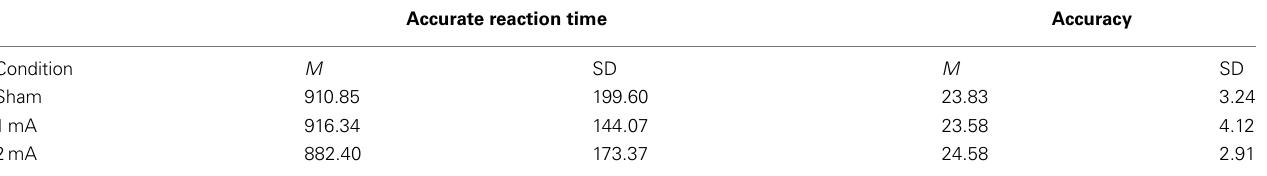
Table 3 | Mean and SD for accurate reaction time and accuracy of Sternberg task. Accurate reaction